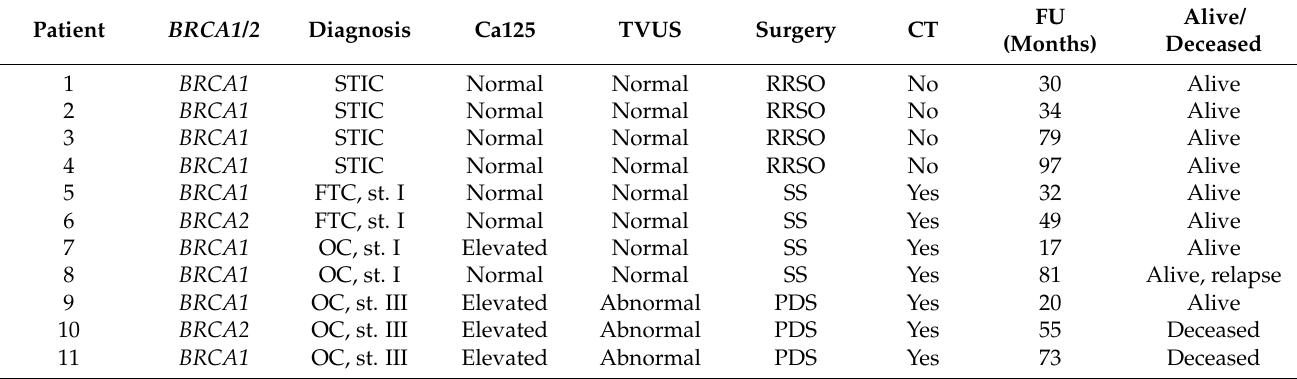
Table 4. Characteristics, Diagnosis, and Treatment of Ovarian Cancer (OC) in BRCA1/2